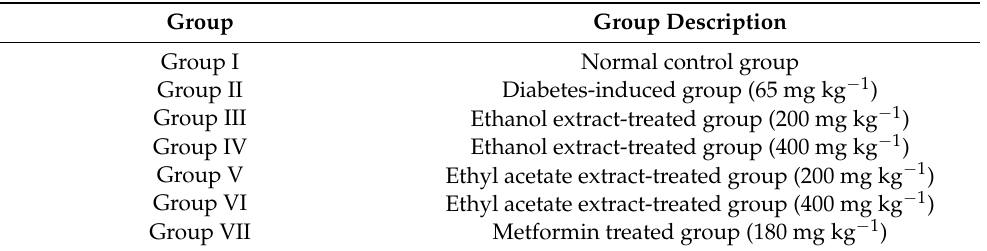
Table 1. Grouping of the animals used to determine the antihyperglycaemic potential of P. tetrastromatica